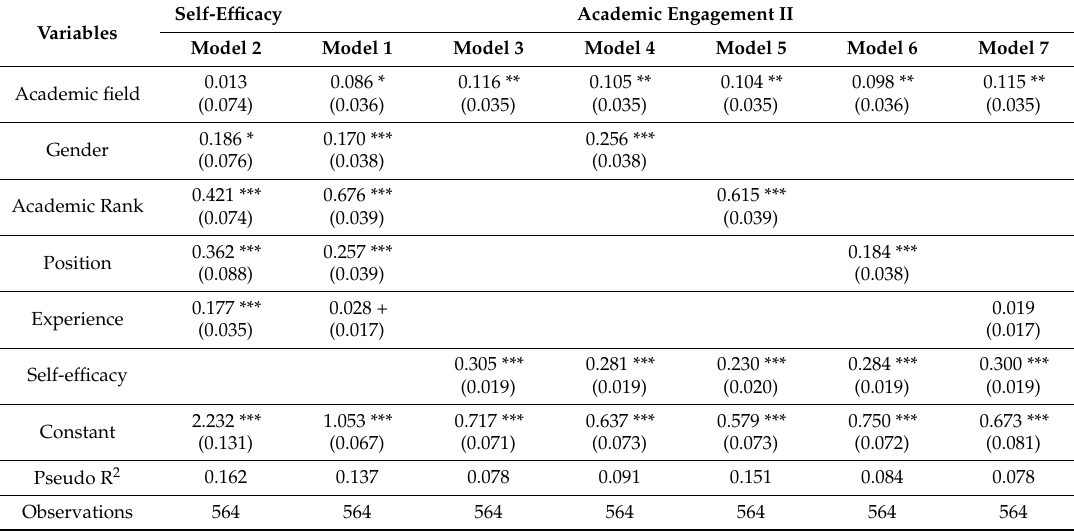
Table 5. Poisson regression results for robustness